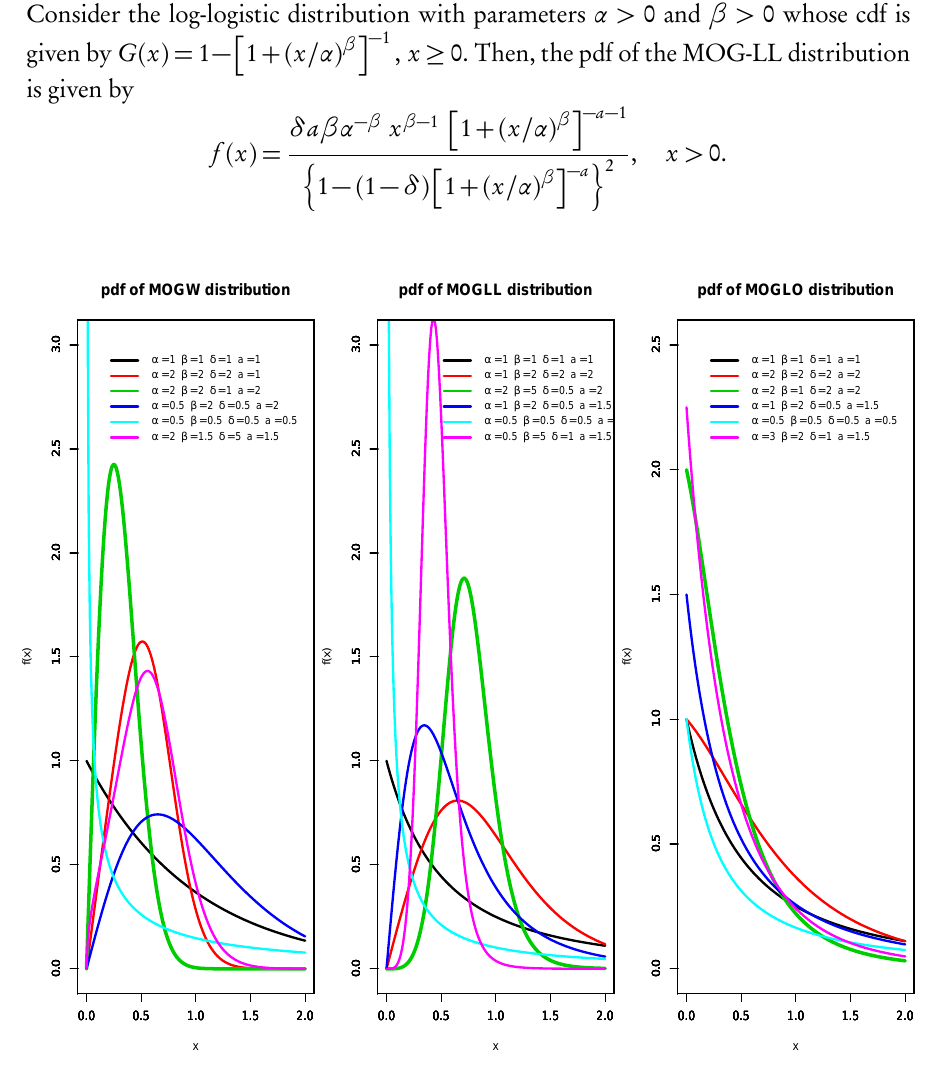
Figure 1 – Pdfs of special MOG-G